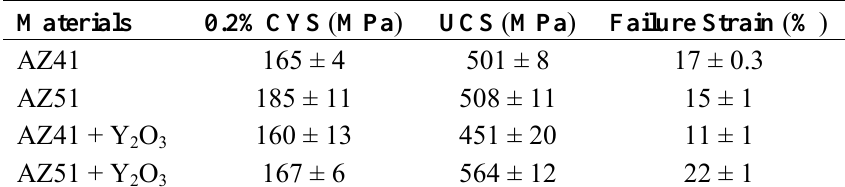
Table 3. Results of room temperature compressive